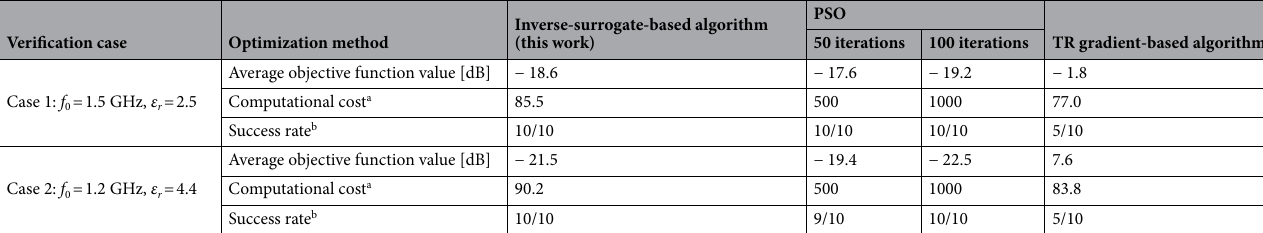
Table 5. Circuit II: optimization results. a The cost expressed in terms of the number of EM simulations of the antenna structure under design. b Number of algorithms runs at which the operating parameters were allocated to satisfy the condition D ( F ( x *), f t ) ≤ D accept .